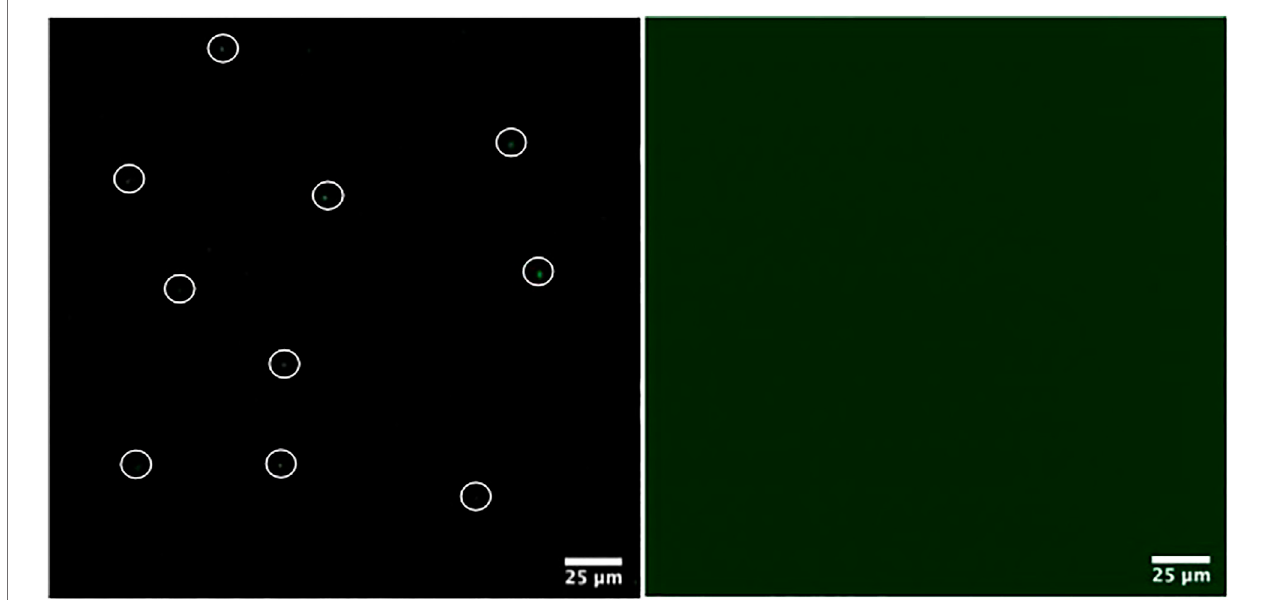
FIGURE 3 | Comparison of liposome packaged (left panel) and free DPTZ-DBTO2 (right panel). Left panel showing liposome packaged DPTZ-DBTO2 (some circled for clarity), from fraction 1 ( Supplementary Figure S2 ), imaged 30 min after PD-10 desalting column separation, once freeze-pump-thawing had been performed. Packaged and free DPTZ-DBTO2 complex gave the same fl uorescence intensity count. See text for details.